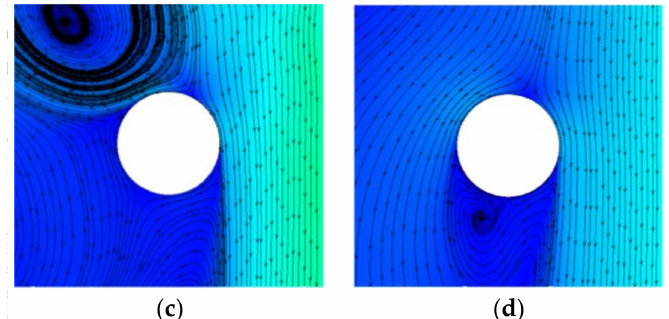
Figure 15. Typical global and local flow structure around the circular cylinder at R = 0.150 with vanes: